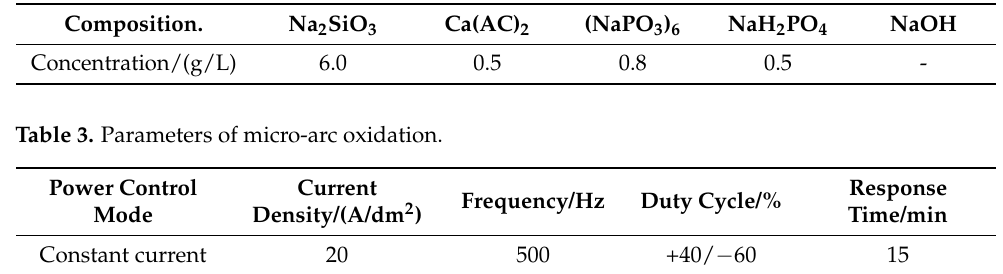
Table 2. Composition of bio-electrolyte for MAO on ZK60 alloy.